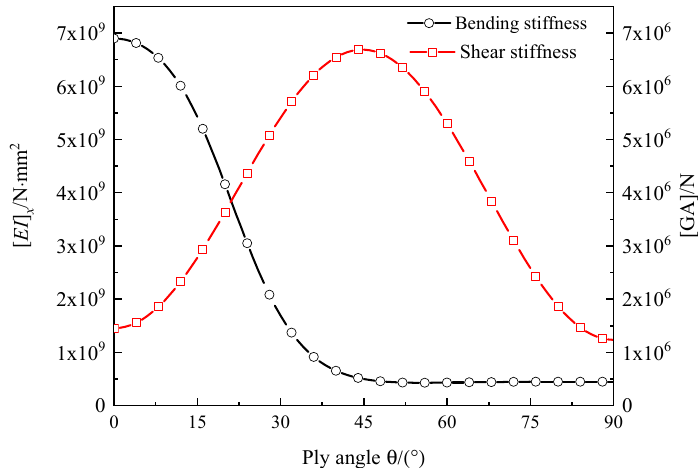
Figure 20. Bending stiffness [ EI ] x and shear stiffness [ GA ] of composite aluminum honeycomb sandwich laminated box beam changing with the ply angle.